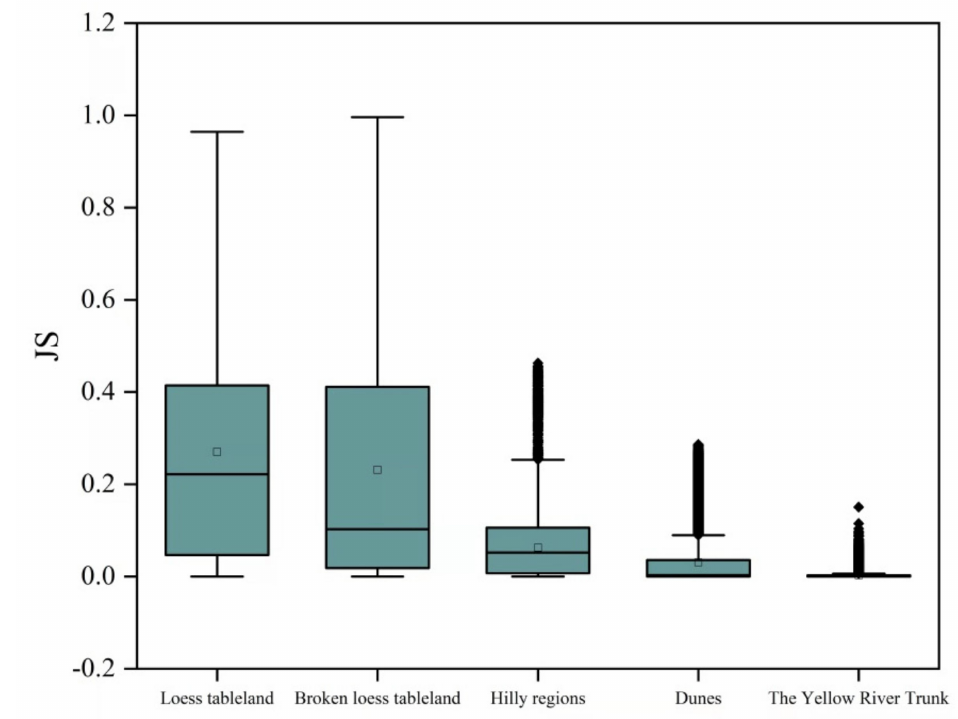
Figure 11. Variation of JS divergence of typical landform in the study area. The square represents the mean value of the corresponding variable. The vertical boxes plot the median, 10th, 25th, 75th, and 90th percentiles of morphological features, and the circle indicates the